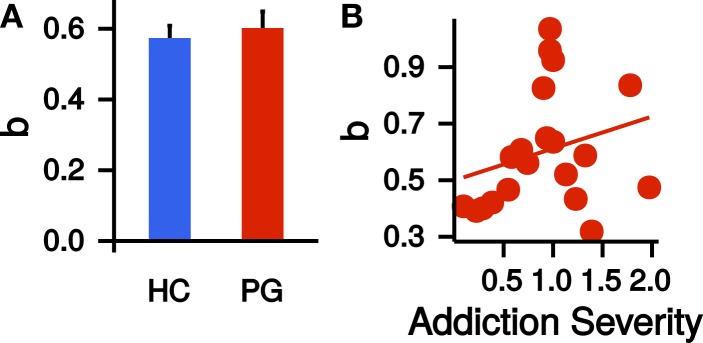
(A) Group difference in the exponent b of the power law time perception (corrected by circle-size estimation). HC, healthy control partici-pants; PG, pathological gamblers. Error bars are indicating SEM. (B) Correlation of exponent b of the power law time perception (corrected by circle-size estimation) with addiction severity scores in PGs (r = 0.26, p = 0.26).